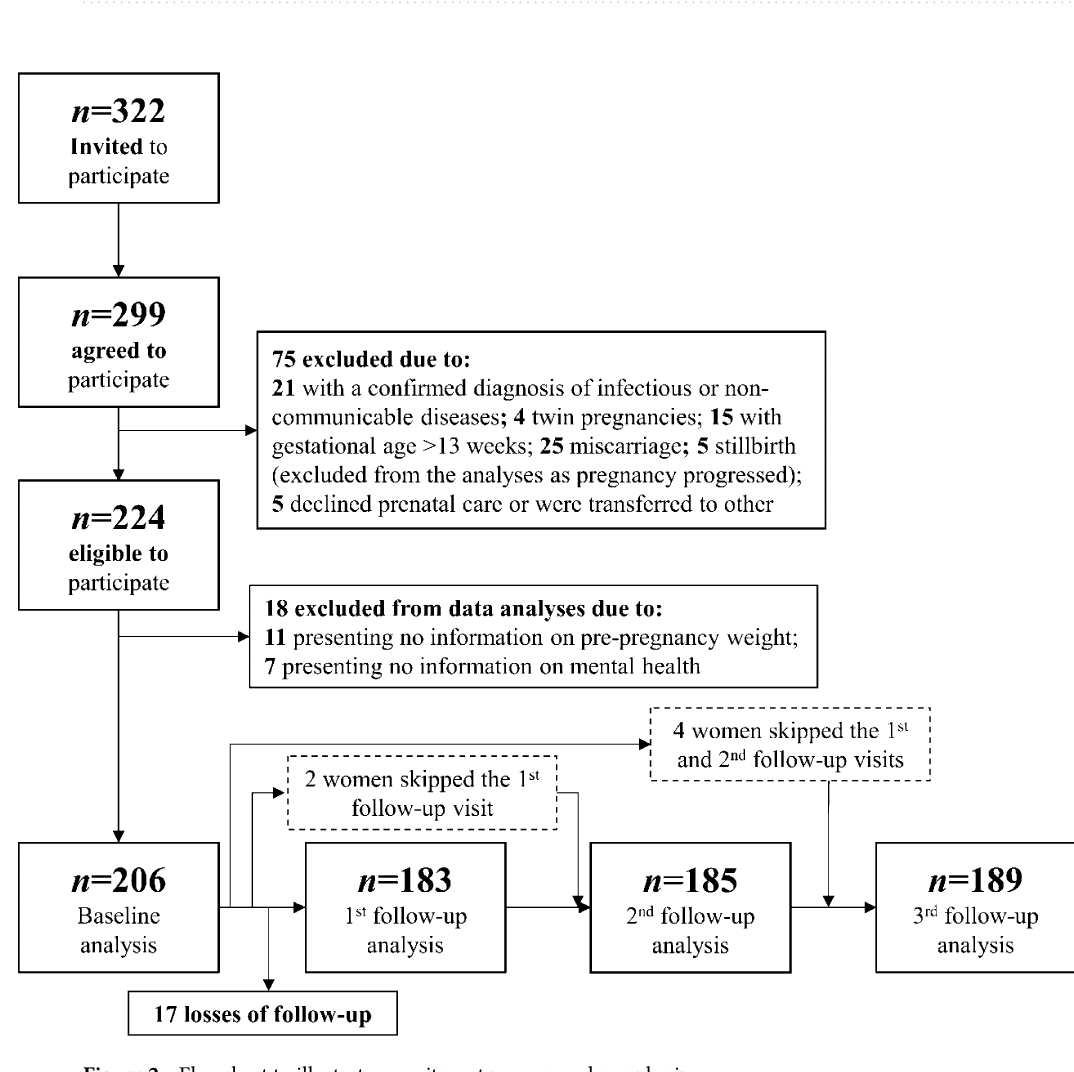
Table 3. Association between maternal mental health during pregnancy and insufficient gestational weight at the third trimester for women followed at a public health care center in Rio de Janeiro, Brazil, 2009–2012. Major depressive disorder, generalized anxiety disorder, and suicide risk were assessed using Mini-International Neuropsychiatric Interview. Persistently depressive symptoms were classified as yes if the women presented Edinburgh Postnatal Depression Scale score ≥ 11 at the three pregnancy trimesters. State anxiety symptoms were measured using the Spielberger State-Trait Anxiety Inventory. Model 1 was not adjusted; Model 2 was adjusted for desire to be pregnant, education, marital status, pre-pregnancy leisure time physical activity, parity, and pre-pregnancy body mass index. CI confidence interval, IRR Incidence rate ratio. a Gestational weight gain adequacy according to Institute of Medicine guidelines (adequate/excessive vs. insufficient weight gain); b p-value refers to Poisson regression.